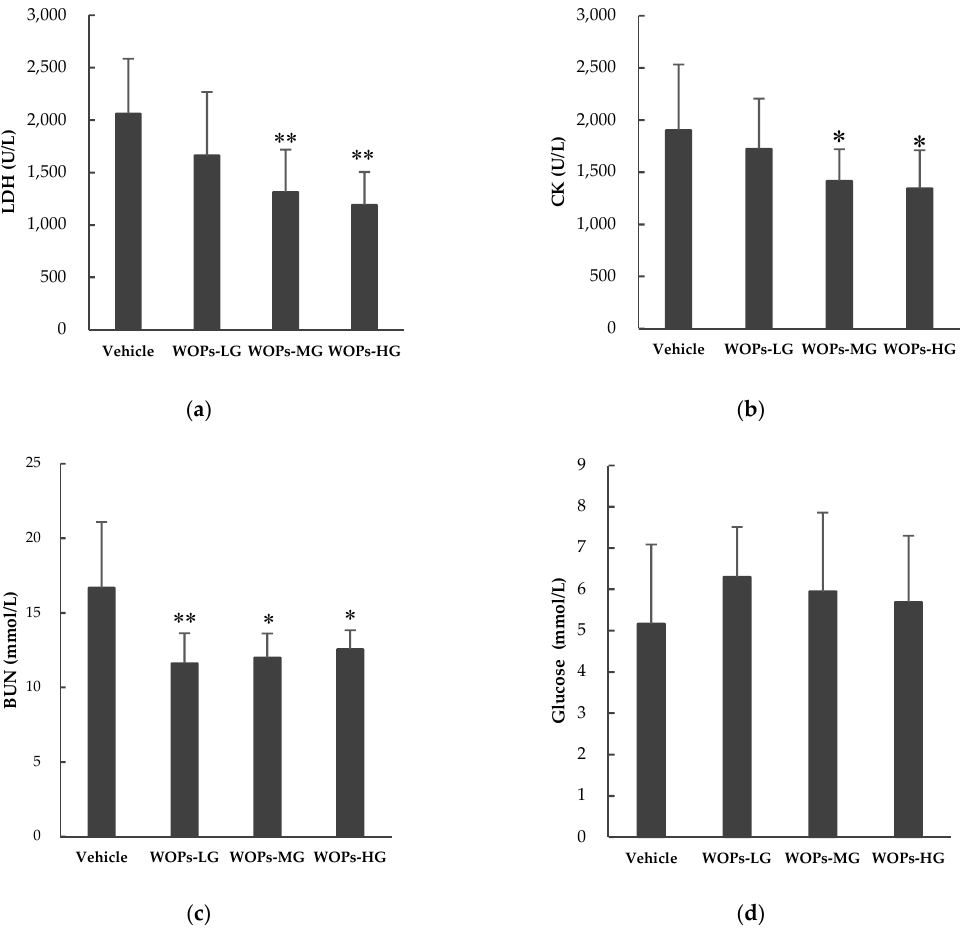
Figure 2. The effects of WOPs on serum biochemical parameters including ( a ) lactate dehydrogenase (LDH); ( b ) creatine kinase (CK); ( c ) blood urea nitrogen(BUN); and ( d ) blood glcouse. Data are expressed as mean ± SD ( n = 10). * p < 0.05, ** p < 0.01 indicate significant difference versus vehicle group. WOPs-LG, walnut oligopeptides low-dose group at a dose of 110 mg/kg; WOPs-MG, walnut oligopeptides medium-dose group at a dose of 220 mg/kg; WOPs-HG, walnut oligopeptides high-dose group at a dose of 440 mg/kg.